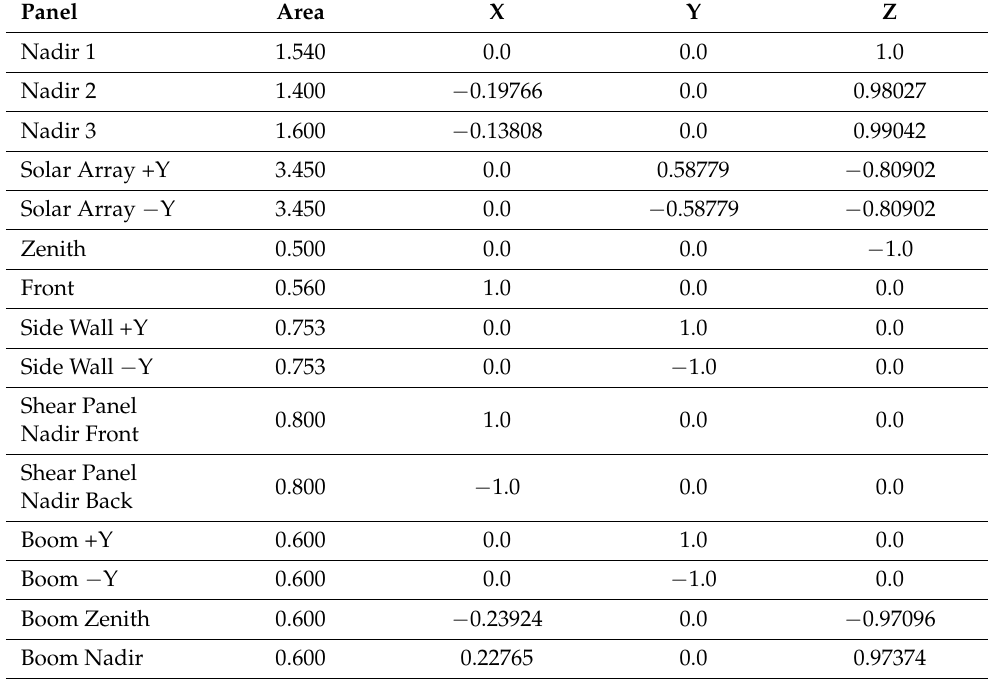
Table 1. Normal vectors of each panel of Swarm-C satellite.